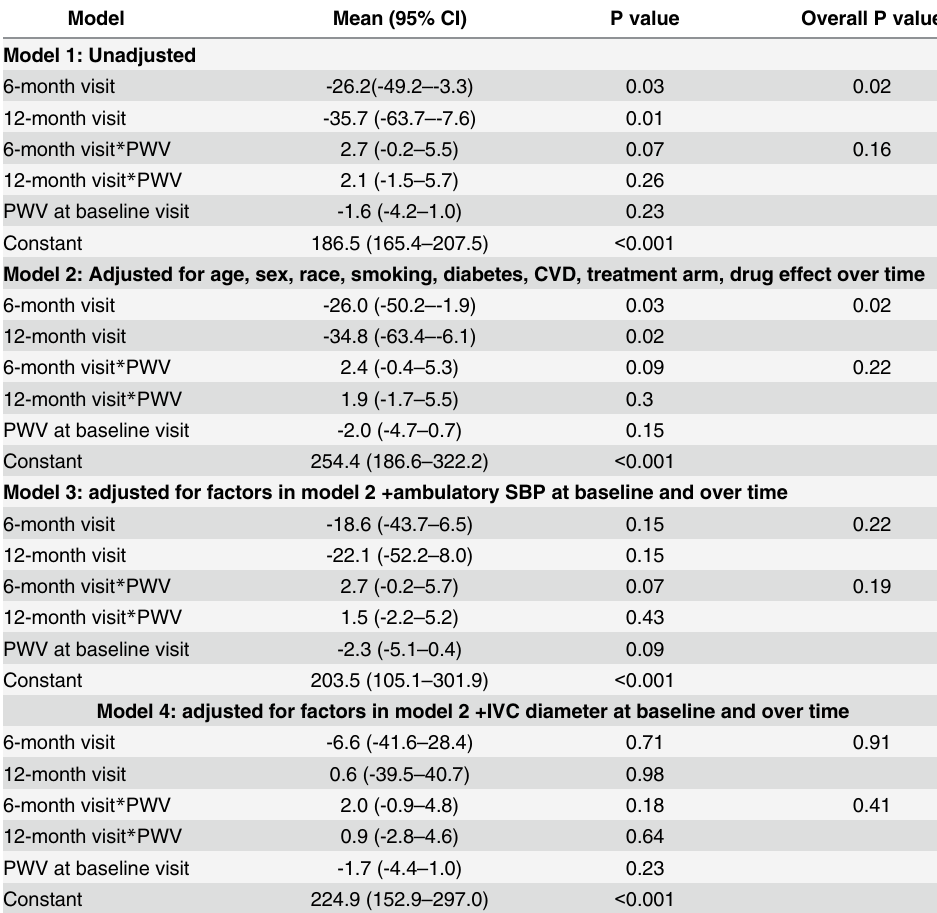
Table 4. Progressively adjusted models of change from baseline in left ventricular mass